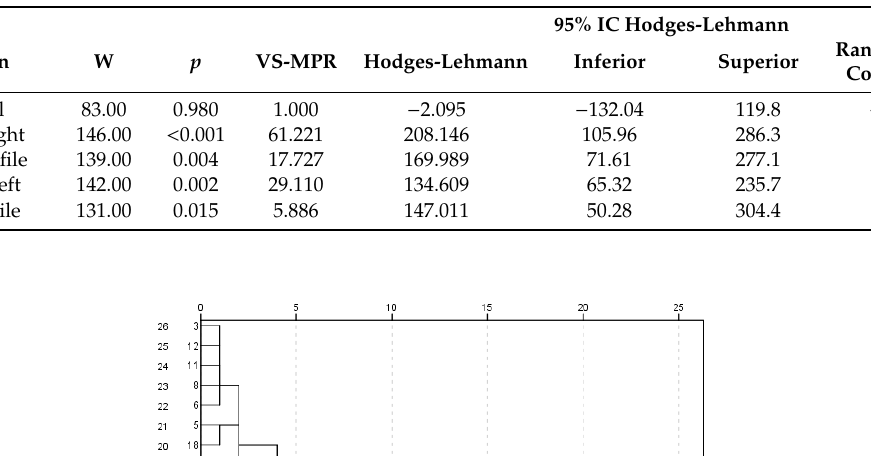
Table 5. Mann–Whitney U test for experimental conditions in the clusters increments ( ∆ ).